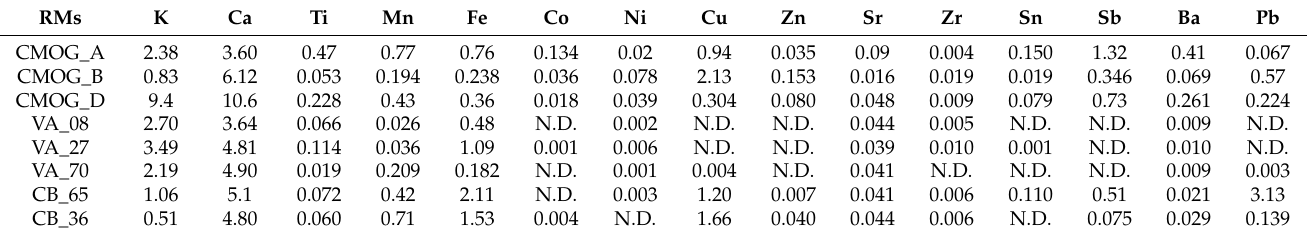
Table 1. Compositions (reported in element weight percent) of the reference glasses involved in this study (relevant elements). Compositions are from: CMOG A, B, and D—([47] and references therein), VA08, VA27—[48]; VA70—[49]; CB65—[50]; and CB36—[51]. The number of significant digits reflects analytical precision as reported in the listed